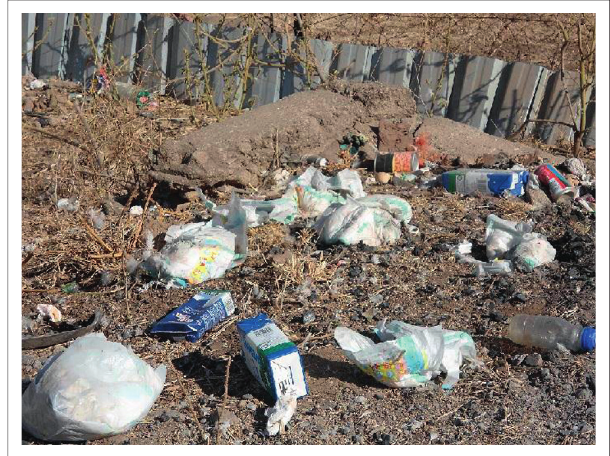
FIGURE 5: A dumping area in the backyard of a respondent.